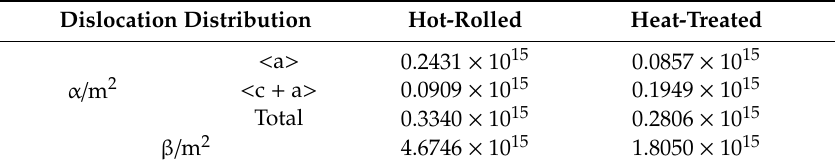
Figure 6. Dislocation distribution maps determined from electron backscatter diffraction (EBSD) measurements of the ( a ) hot-rolled specimen and ( b ) heat-treated specimen. Table 3. Dislocation densities of the hot-rolled and heat-treated titanium alloys.